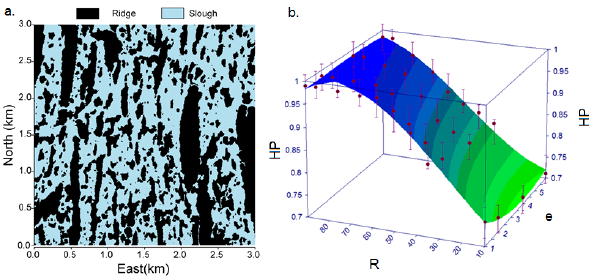
Figure 1. (a) Example reference ridge (black) and slough (blue) landscape; (b) third-order polynomial surface of hydroperiod (HP) vs. anisotropy ( e) and ridge patch density (% R ) ( R 2 = 0.98) based on the results of numerical simulation of surface water flow using a hydrodynamic model (SWIFT2D; Schaffranek,